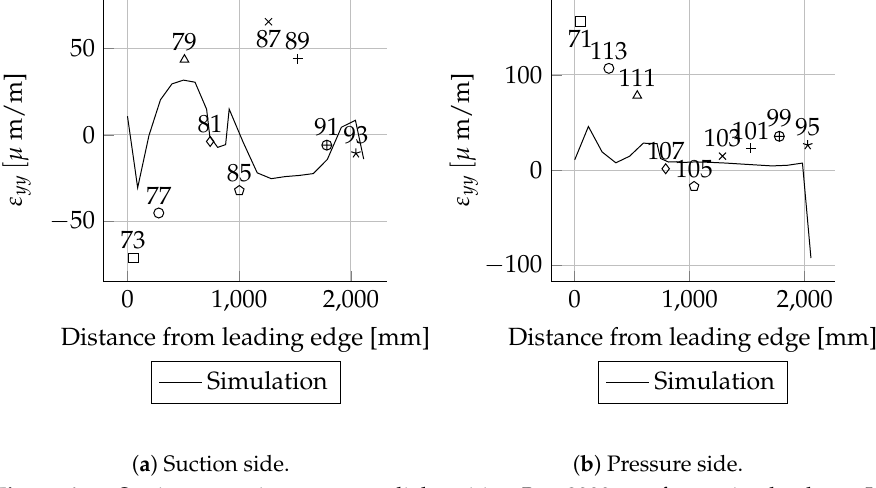
Figure A61. Strain comparison ε TT at radial position R = 8000mm for torsion load case LC_2.